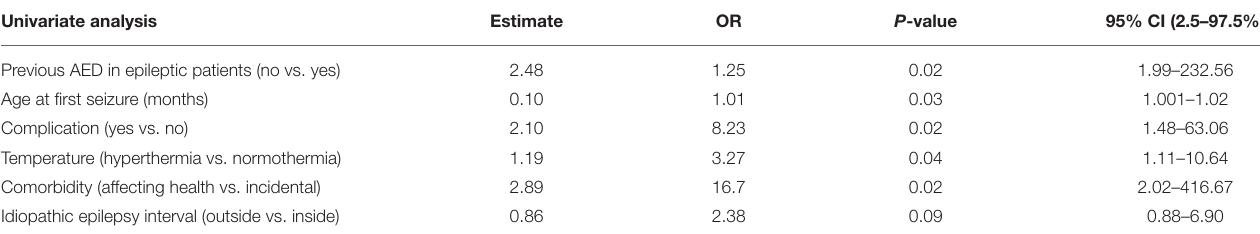
TABLE 1 | Univariate analysis. Univariate analysis